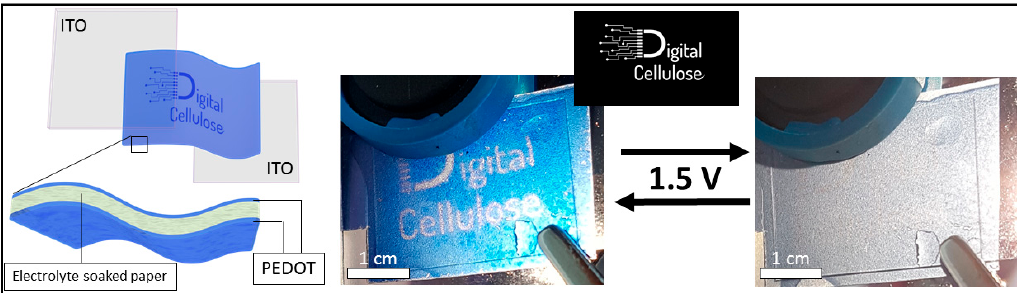
Figure 4. Schematics and photographs of paper electrochromic devices using electrolyte-soaked filter paper.